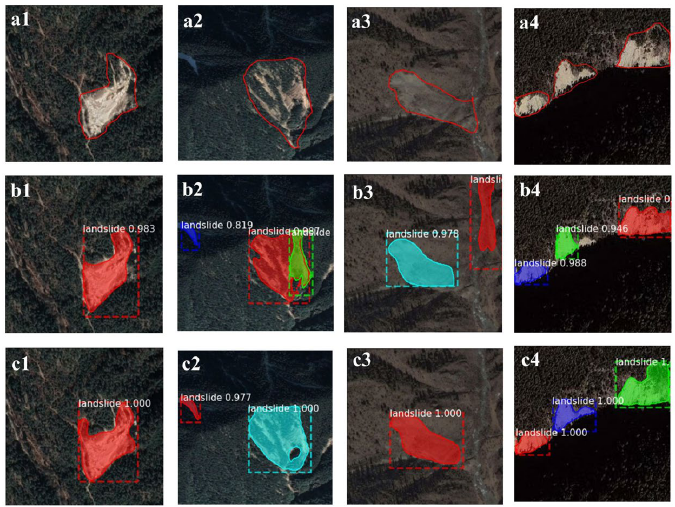
Figure 10. New landslide detection and segmentation results using Mask R-CNN based on the different backbones. ( a1 – a4 ) represent different landslides: ( a1 ) is a single intact landslide with vege- tation cover; ( a2 ) is a broken-shaped landslide with vegetation cover; ( a3 ) is close to the surrounding ground features; ( a4 ) is multiple landslides in an image. ( b1 – b4 ) are the results using resnet-50 as the detection backbone. ( c1 – c4 ) are the results using resnet-101 as the detection backbone. Table 1. New landslide detection results using Mask R-CNN with different backbones.